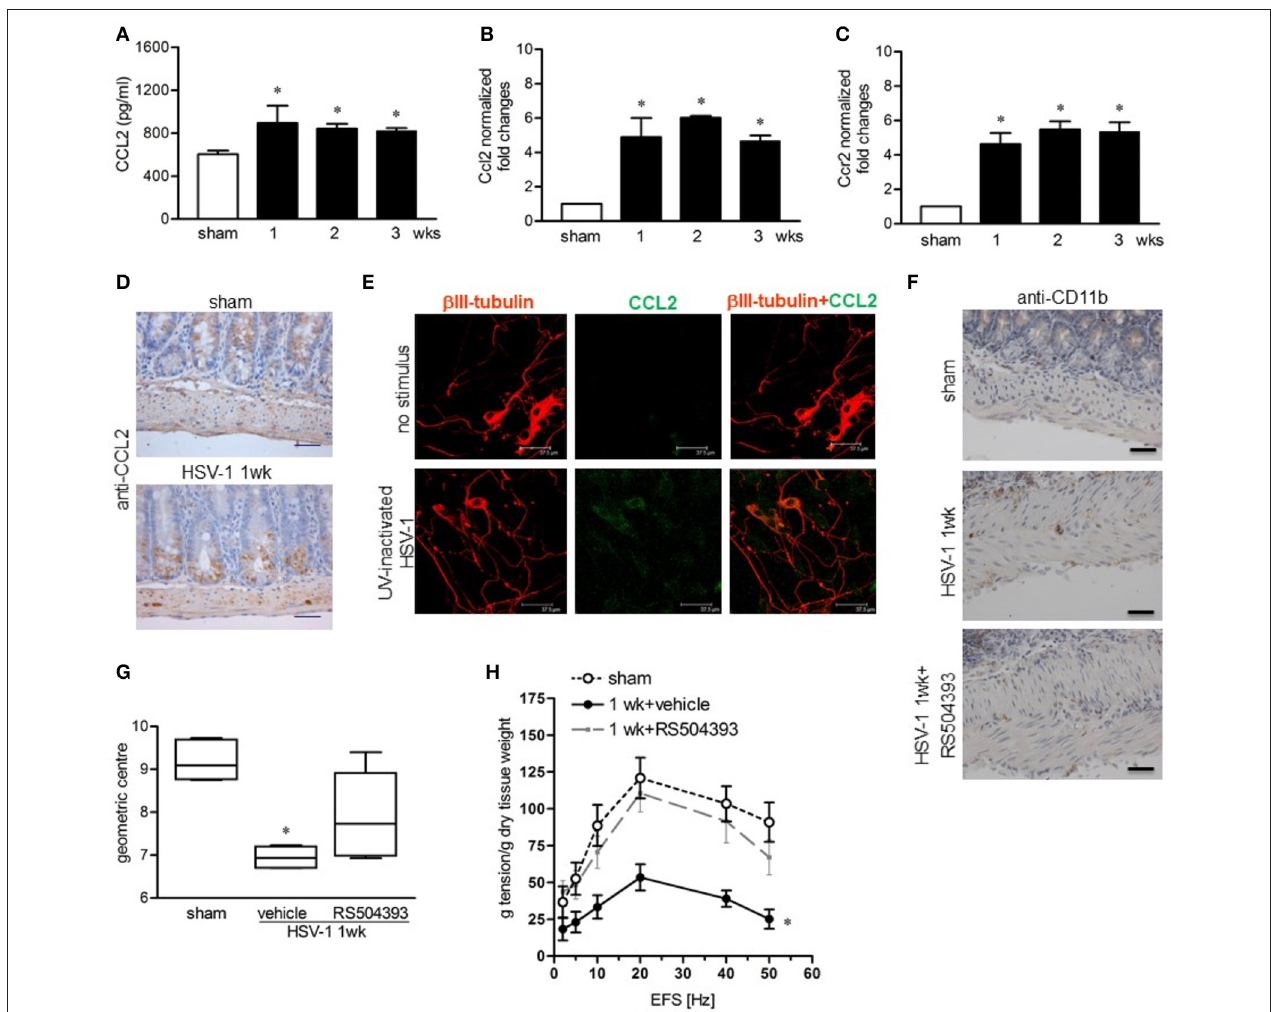
FIGURE 8 | CCL2 is required for macrophage recruitment and intestinal dysmotility during HSV-1 infection (A) CCL2 levels were quantified by ELISA in LMMP extracts obtained from sham and HSV-1 strain 16 infected mice. (B) Quantitative RT-PCR analysis of Ccl2 mRNA and (C) Ccr2 mRNA in LMMP from sham and HSV-1 strain 16 infected mice. Data were normalized to ribosomal 18S RNA ( Rn18S ) and reported as fold change. (D) Immunohistochemistry for CCL2 on sections of ileum collected from sham and HSV-1 strain 16 infected mice. Scale bars: 40 µ m. (E) Enteric neurons cultured from LMMP of non-infected mice were exposed for 16h to UV-inactivated HSV-1. Cells were then fixed and probed with anti- β III tubulin and anti-CCL2 antibodies. Cells were visualized under a confocal microscope. Scale bar = 37.5 µ m. (F) At 1-week post-infection, mice were treated with RS504393, a highly selective CCR2 chemokine receptor antagonist. Immunohistochemistry on sections of ileum revealed decreased infiltration of CD11b + cells. Scale bars: 40 µ m. Images are representative of three separate experiments. (G) At 1-week post-IG HSV-1 inoculum, RS504393 or vehicle treated mice were administered with non-absorbable FITC-labeled dextran and sacrificed 60min later. Intestinal transit was reported as the geometric center of distribution of the fluorescent probe throughout the ileum. (H) EFS-elicited contractions in segments of ileum of sham and HSV-1 infected mice treated with RS504393 or vehicle. Data are represented as mean ± SEM. n = 6–8 mice per group. *Denotes P < 0.01 compared to sham infected